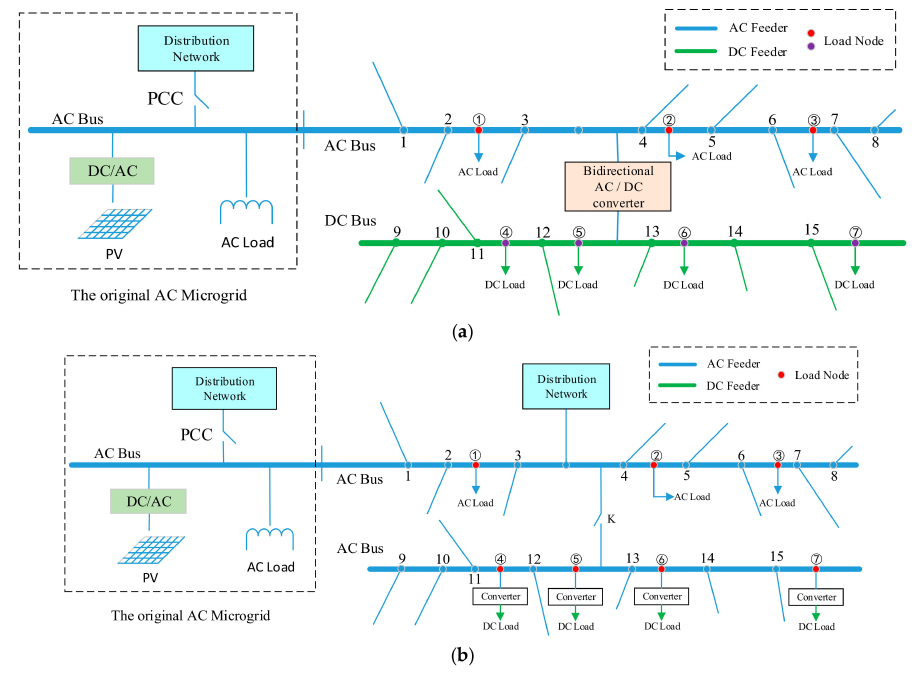
Figure 4. Schematic diagram of the microgrid extended grid structure in a certain area ( a ) Case I; ( b ) Case